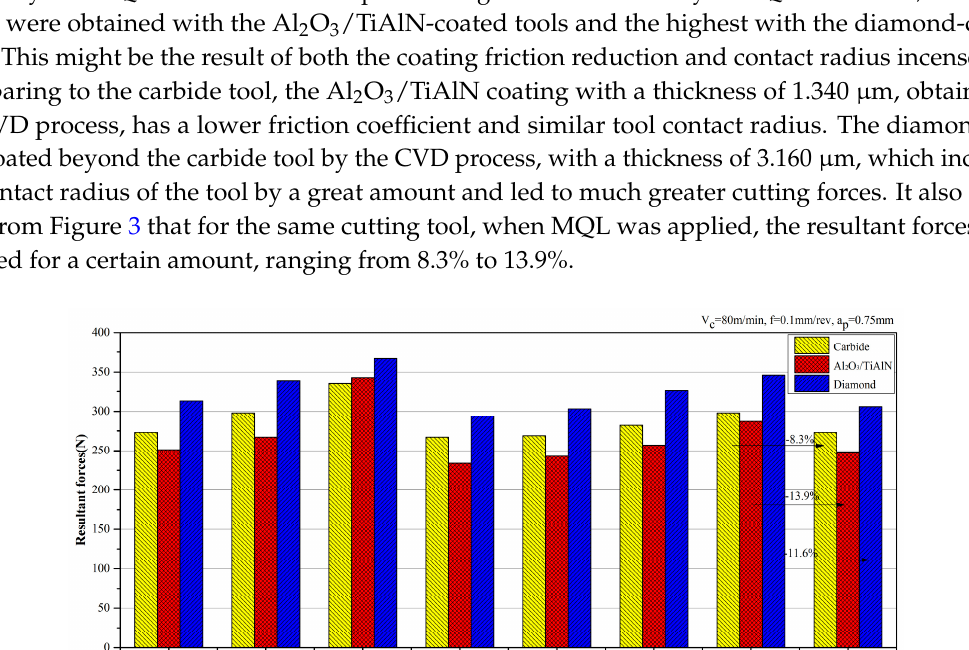
Figure 5. Cutting temperature comparison under dry and MQL conditions.